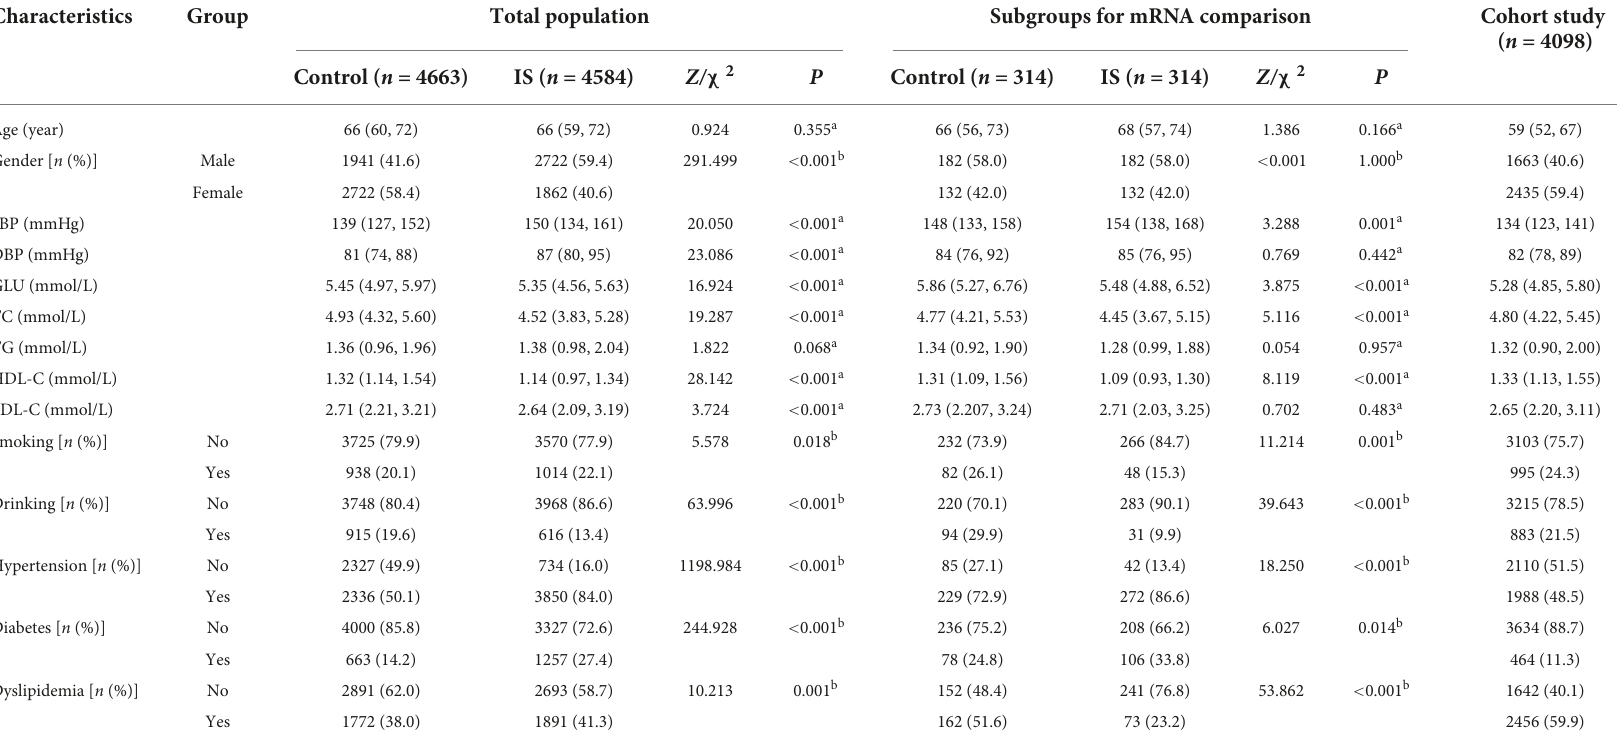
TABLE 1 Demographic and clinical characteristics of the study